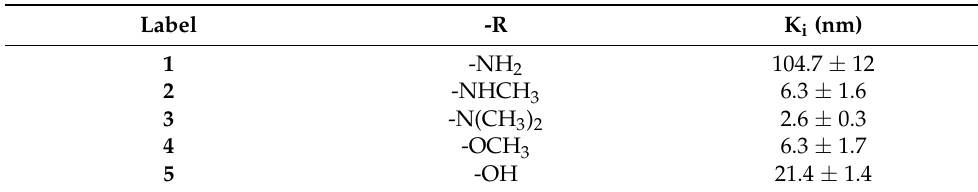
Table 1. Inhibition constants of iodinated chalcone derivatives against 4-[125I]iodo-4 (cid:48) -dimethyamino- calchone ([ 125 I] 3 ) as adapted from